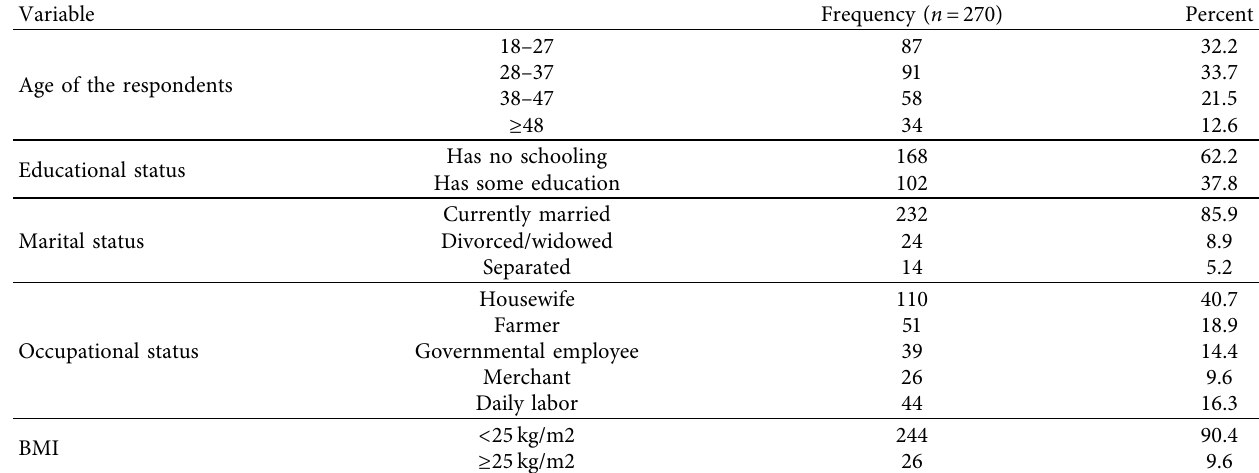
Table 1: Distribution of study participants by their sociodemographic